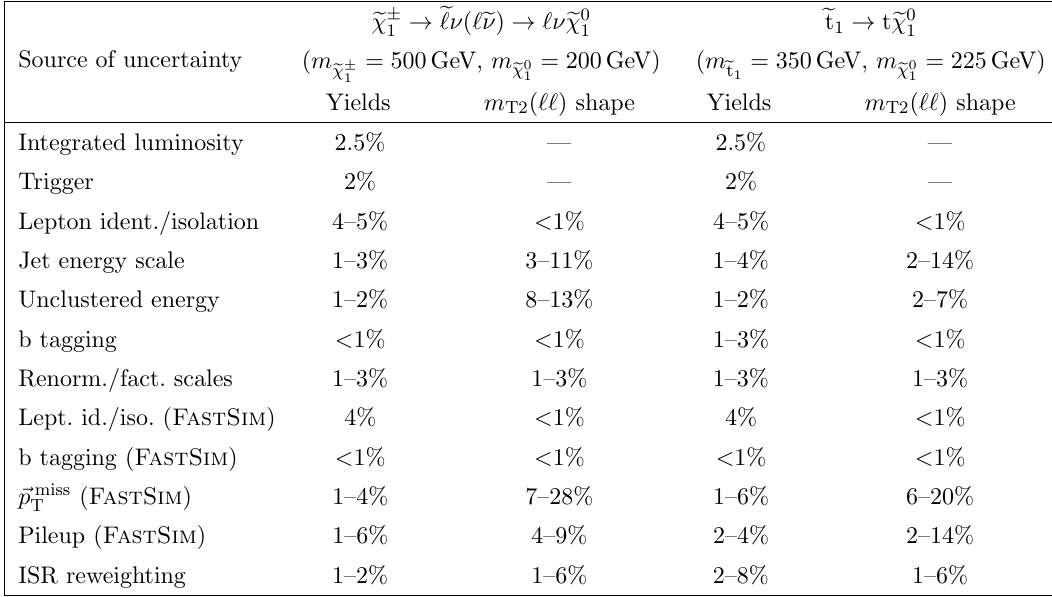
Table 6 . Same as in table 5 for two representative signal points, one for chargino pair production and one for top squark pair production.